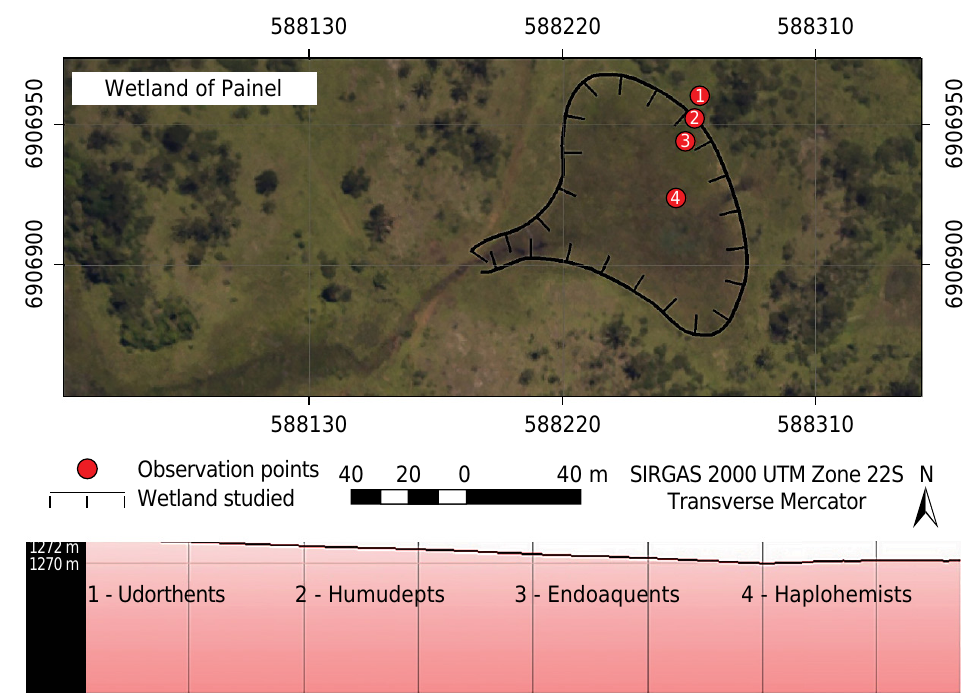
Figure 3. Location of the wetland in the municipality of Painel (PA), SC, and elevation profile. Distance between points 1 and 2: 16 m; 2 and 3: 8 m; 3 and 4: 10 m. Figure of the Aerophotogrammetric Survey of the State of Santa Catarina, Brazil, 2010.